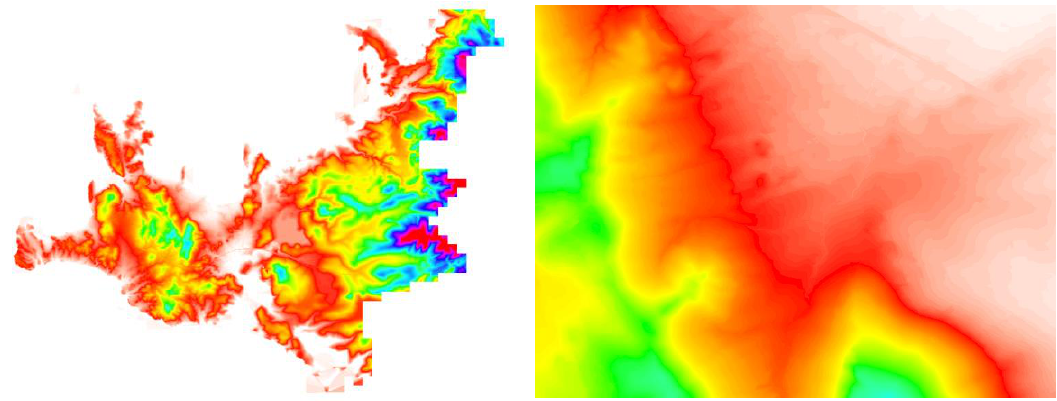
Figure 9. Overview of the generated grid DTM from manually measured terrain data of the whole Cesme area ( left ) and a zoomed view ( right ).